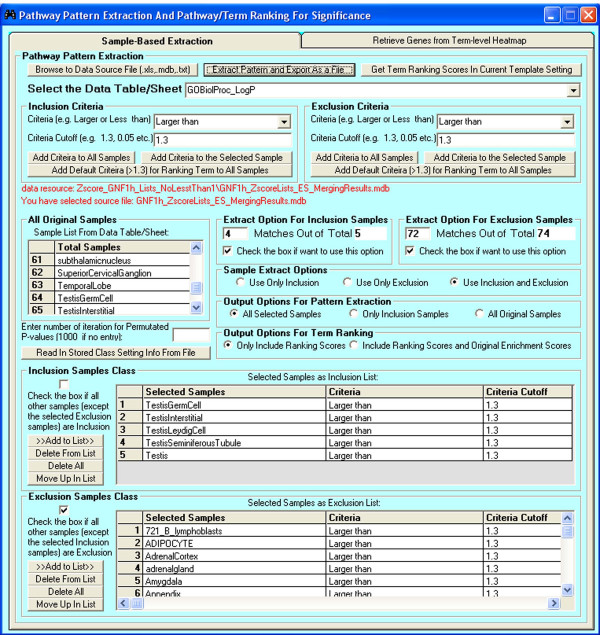
The interface for pathway pattern extraction of the PPEP. User can browse to the data sources (e.g., a matrix of enrichment scores) in multiple file formats (text file, Microsoft Excel file and Access file), select Inclusion samples and Exclusion samples from sample list, set criteria for both Inclusion and Exclusion samples. There are also Extract Options for both Inclusion and Exclusion samples so that a term with a portion of samples meets the criteria can be selected.